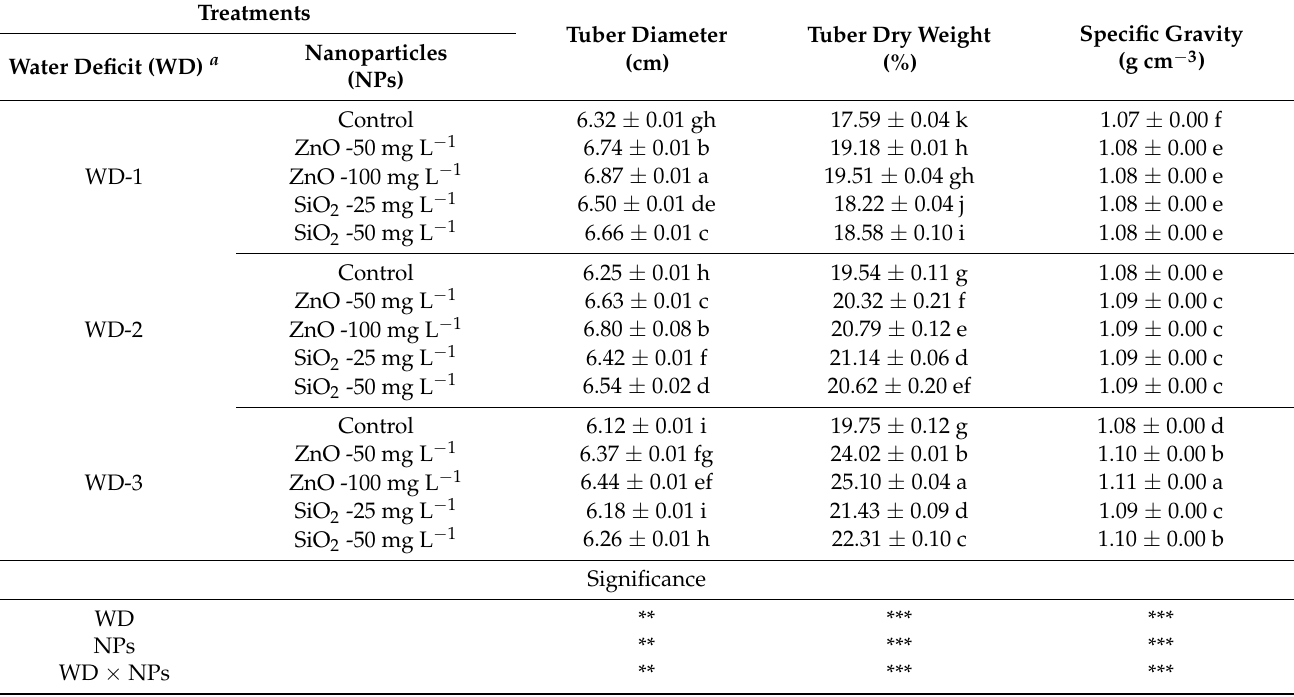
Table 3. Influence of foliar nanoparticles (NPs) on physical traits of potato grown under different water deficit conditions (irrigation